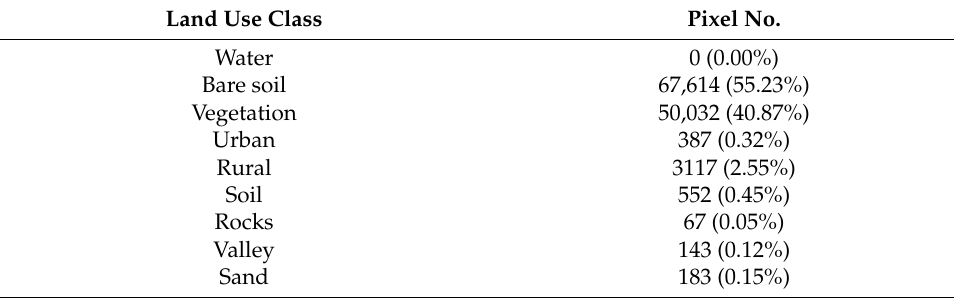
Figure 10. Wildfire susceptibility maps obtained from SVR-WOA, SVR-SA, ANFIS-WOA, and ANFIS-SA models. Table 4. Overlap of high and very high susceptibility classes with each land use